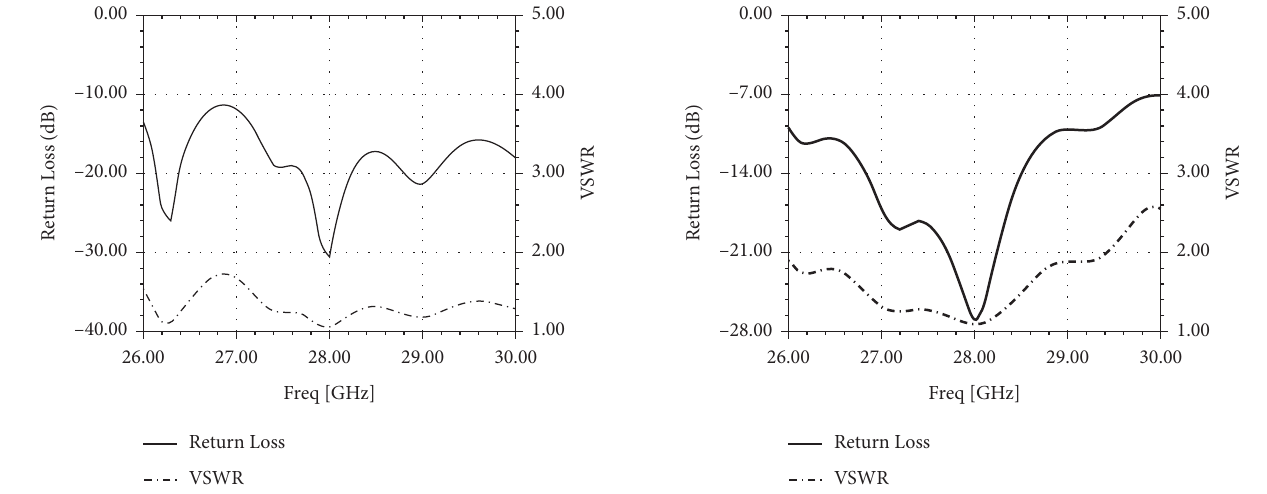
Figure 5: Designed 8 × 8 broadside uniform array antenna sim- ulation results of return loss (S11) and